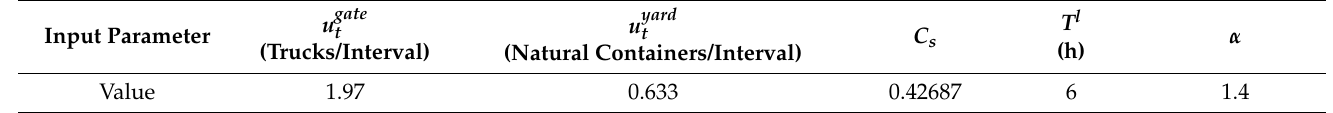
Table 1. Values of other input